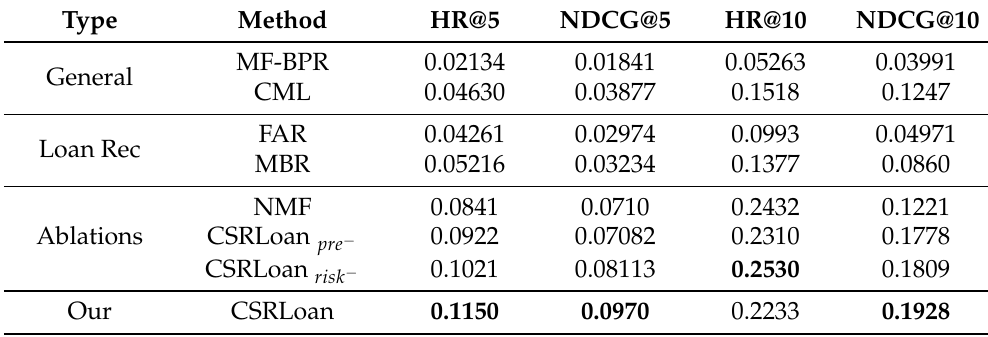
Table 5. Performance comparison of different methods in terms of HR@5, NDCG@5, HR@10, and NDCG@10. The bold values indicate the best